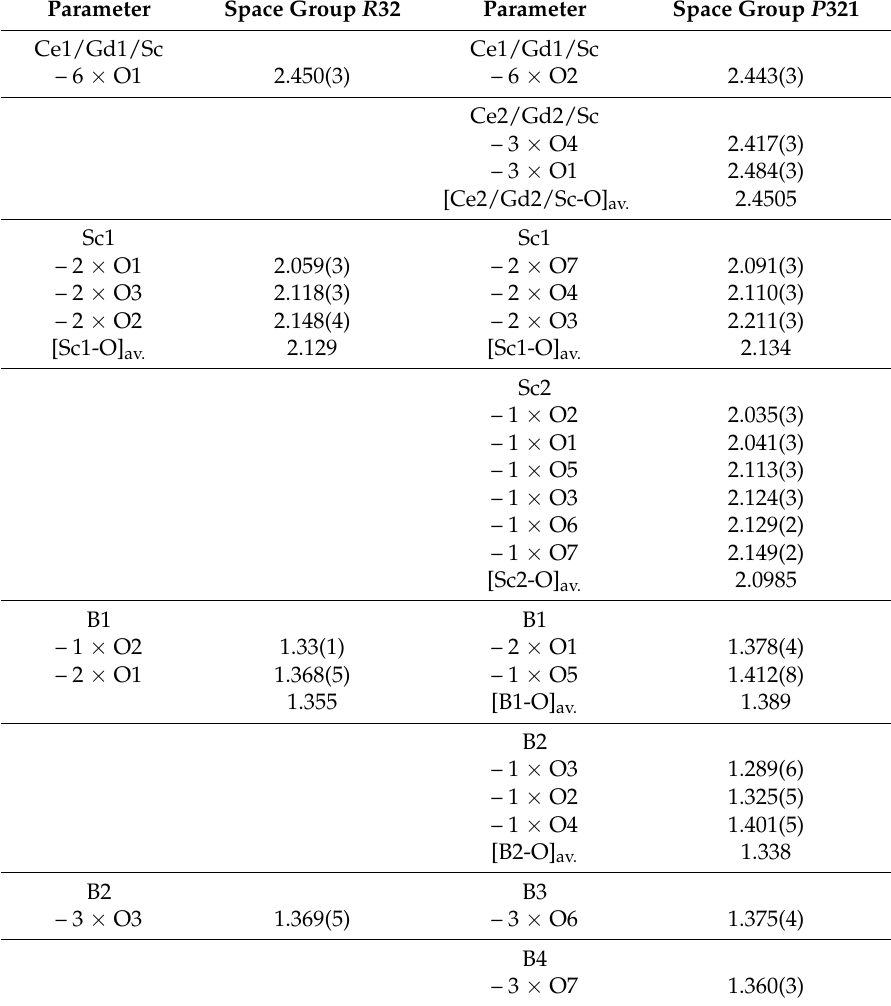
Table 4. Main interatomic distances in the structure of of (Ce 0.80 Gd 0.20 )Sc 3 (BO 3 ) 4 solid solution in the space group R 32 and P 321 according to the XRD data (Ag K α